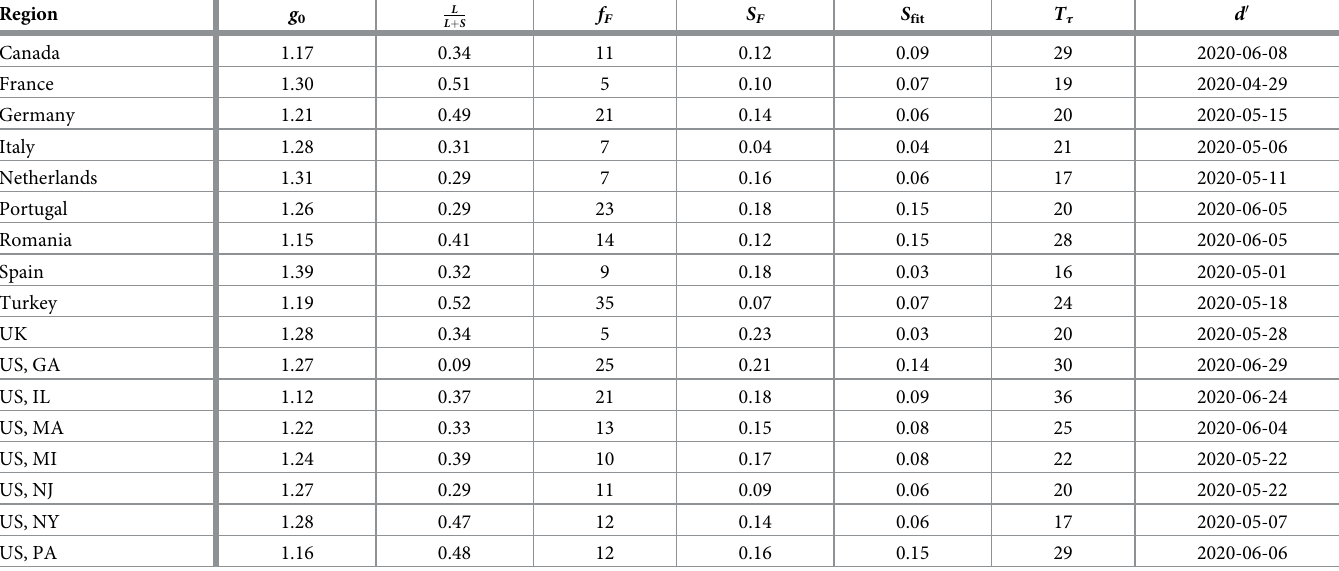
Table 1. Model and data analyses parameters. The effective reproduction factor g 0 estimated from the ( F , Δ F ) representation, the relative fraction L /( L + S ) of long-term control, defined by Eq (8), together with the rescaling factor f F and the accuracy S F of fatalities to case-count scaling, defined by Eq (6). The equivalent accuracies of the fits presented in Fig 4 are given by S fit . Also listed is the timescale T used for evaluating F before / F after (the number of fatalities per time before/after the peak) in Fig 5, and the τ cut-off date d 0 , given by the date at which the daily new cases Δ X of the first peak of the COVID-19 outbreak have dropped by 70% with respect to the maximum.